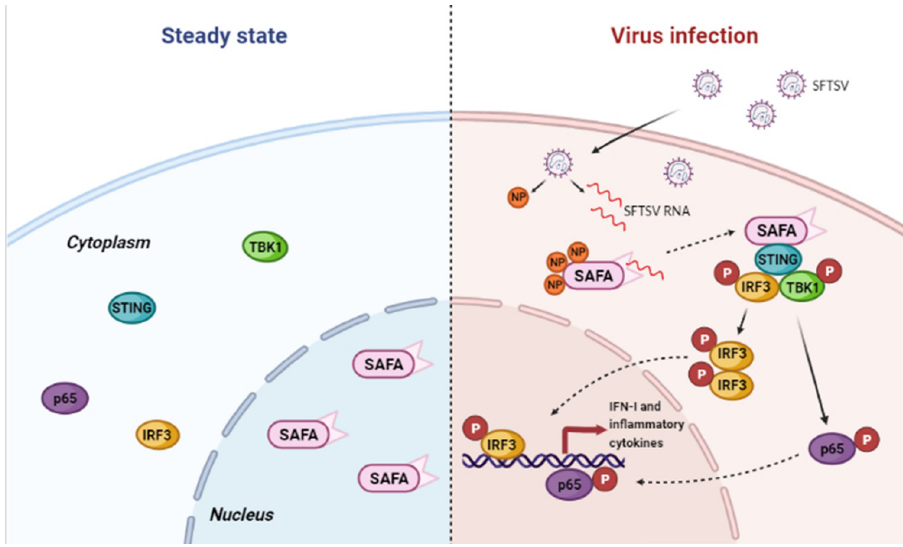
Fig 8. Schematic model illustrating the role of SAFA in sensing cytoplasmic RNA virus SFTSV infection. SAFA remains in the nucleus in the resting state. Under SFTSV infection, SAFA is retained in the cytoplasm by interaction with SFTSV NP. Cytoplasmic SAFA recognizes SFTSV RNA, triggers activation of the STING-TBK1 pathway, and then promotes type I interferon and inflammatory responses against SFTSV infection.